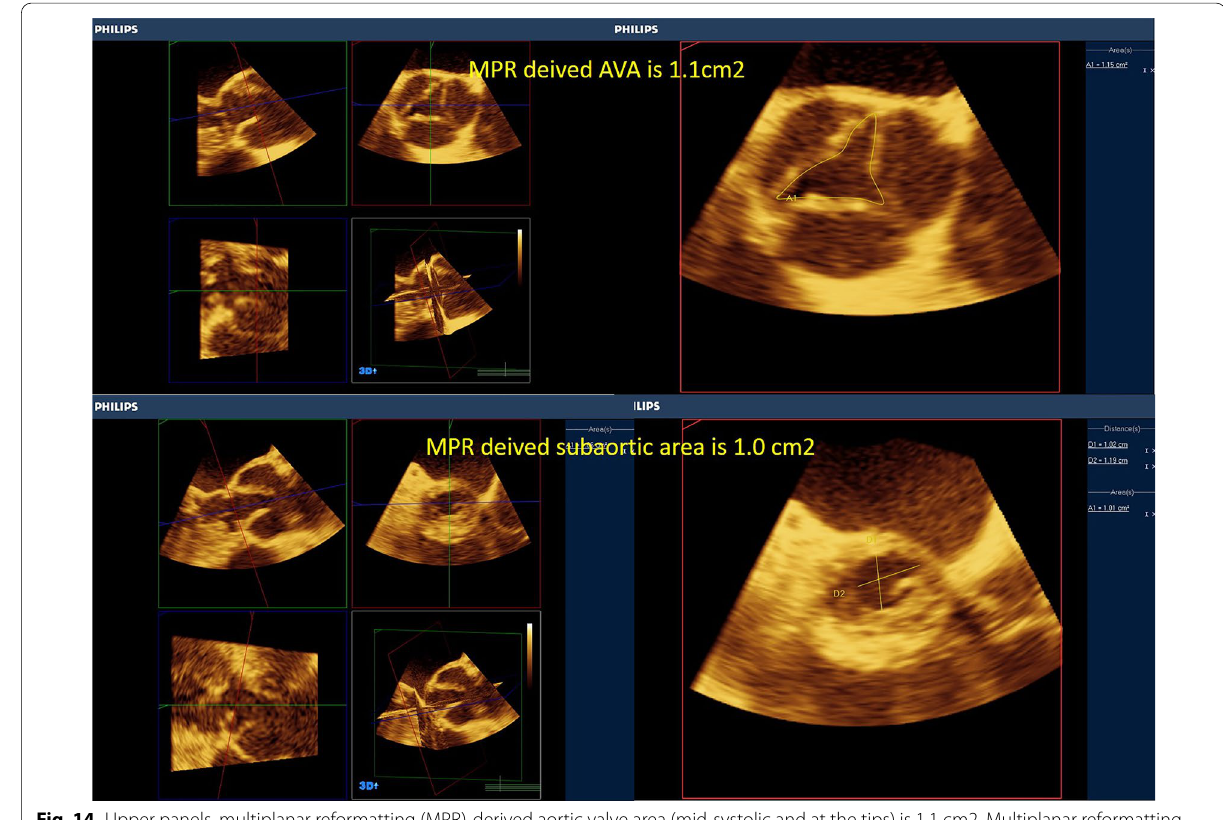
Fig. 14 Upper panels, multiplanar reformatting (MPR)‑derived aortic valve area (mid‑systolic and at the tips) is 1.1 cm2. Multiplanar reformatting (MPR)‑derived area of the LVOT at the level of the subaortic membrane is 1.0 cm2